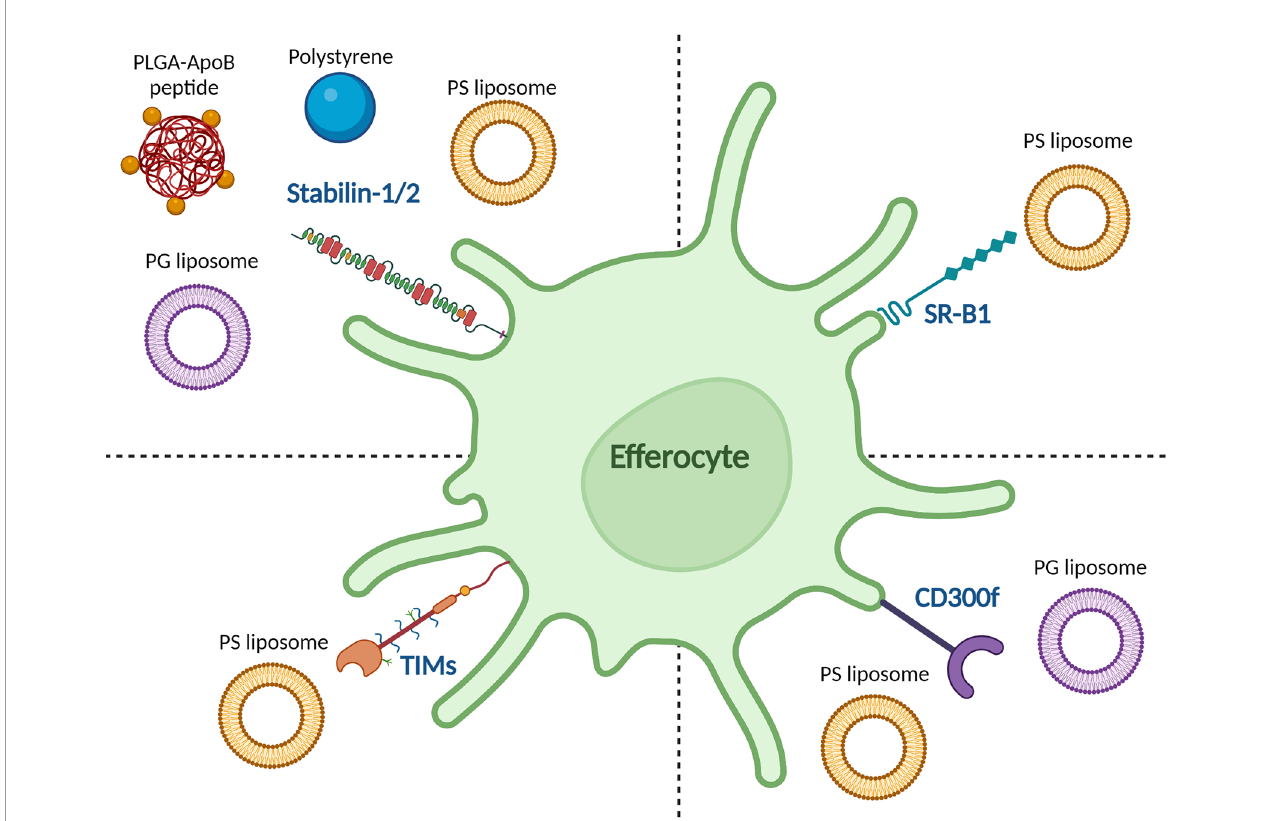
FIGURE 1 | Reported binding of tolerance-inducing nanoparticles to efferocytic receptors on APCs. The stabilin-1/2 receptor was reported to bind to anionic polystyrene beads, apolipoprotein B (ApoB)-peptide-functionalized poly(lactic-co-glycolic acid) (PLGA) nanoparticles, and anionic phosphatidylserine (PS) and phosphatidylglycerol (PG) liposomes. The T cell/transmembrane, immunoglobulin, and mucin (TIM) receptor family recognize PS liposomes as does scavenger receptor class B type 1 (SR-B1). CD300f recognizes both PS and PG